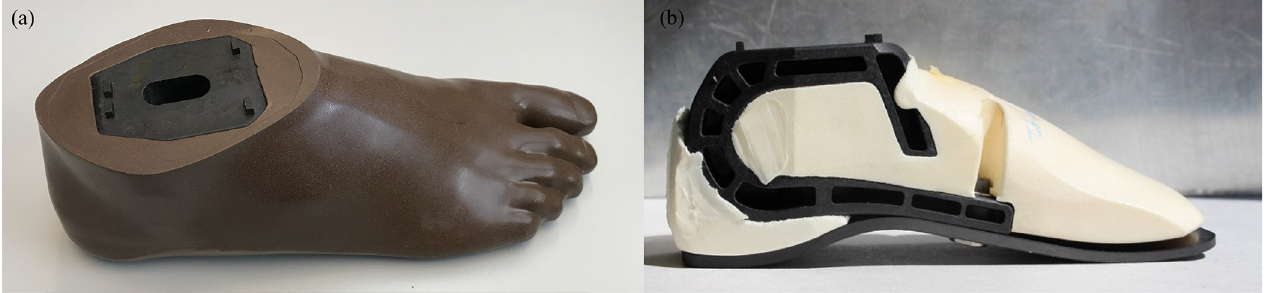
Fig 7. The final aspect of the foot prototype. (a) A prototype foot over-injected with a cosmetic shell. (b) Assembly of the keel, blade, and foam before the final over-injection.